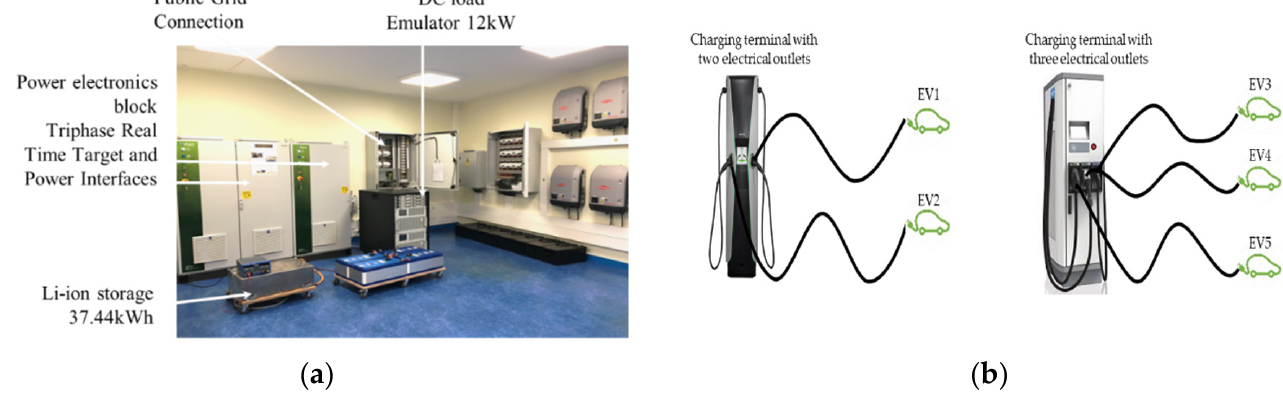
Figure 17. ( a ) Testbed for the IIREV experimental platform and ( b ) representative image of the multi-outlet charging terminals. Table 3. Real-time experiment parameter values.